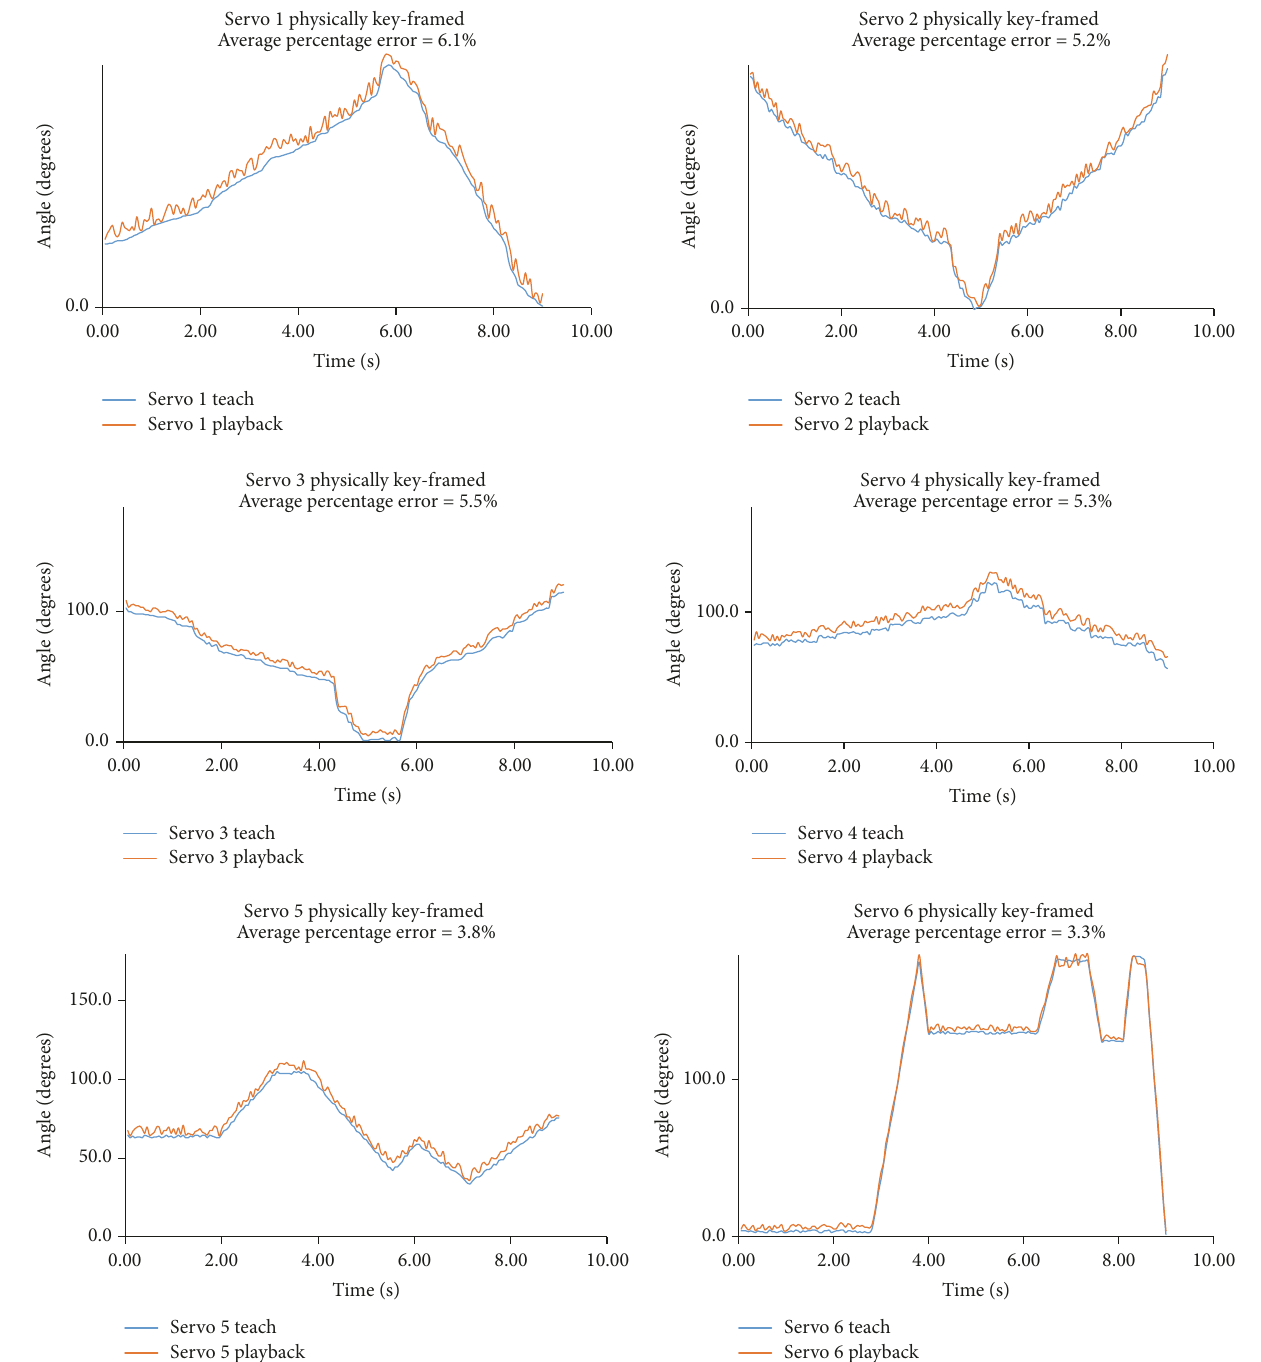
Figure 5: Servo values during the “teach” and “playback” stages of a surgical exercise (peg transfer).